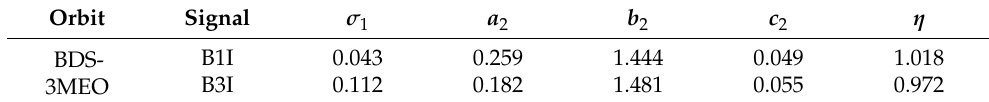
Table 4. Parameters of constructed models with single inflation factor.